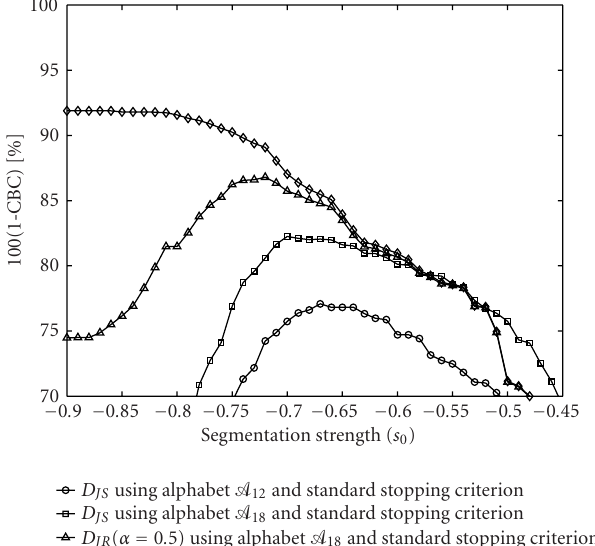
Figure 13: Accuracies of recursive segmentation for di ff erent thresholds of segmentation strength using Jensen-Shannon and Jensen-R´enyi divergences with (cid:1) 12 and (cid:1) 18 alphabets and two stop- ping criterions for the genome of bacterium Borrelia burgdorferi .